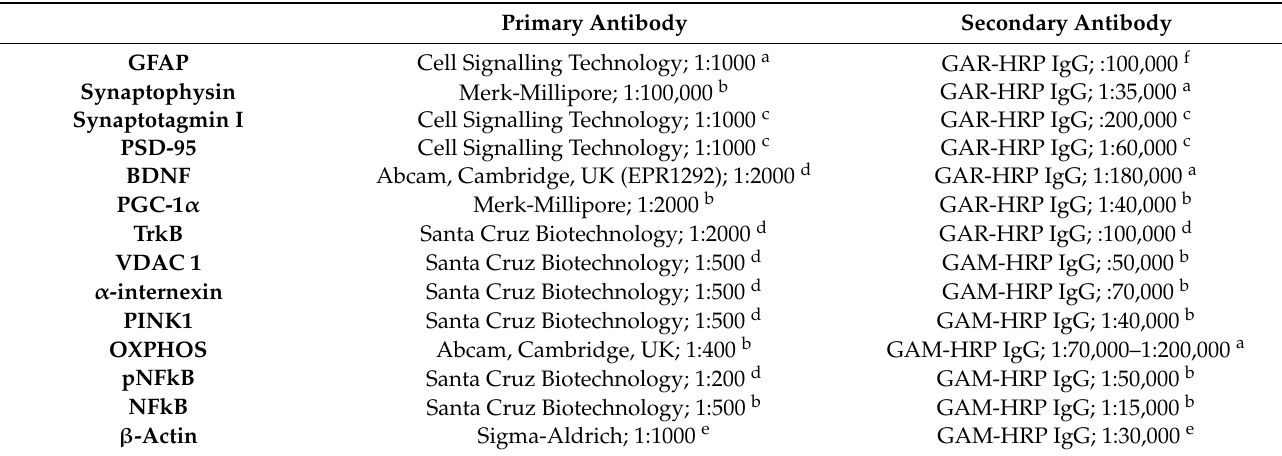
Table 2. Dilutions of primary and secondary antibodies used for Western